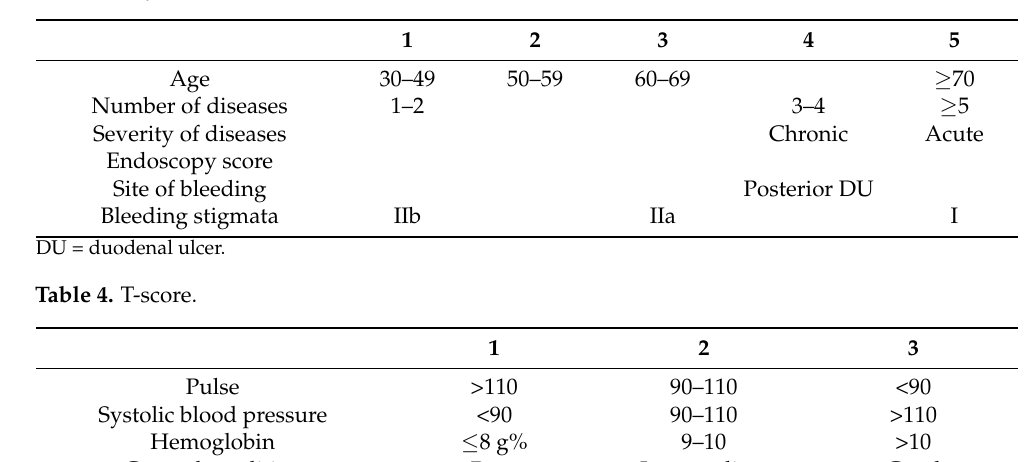
Table 3. Baylor score [28].